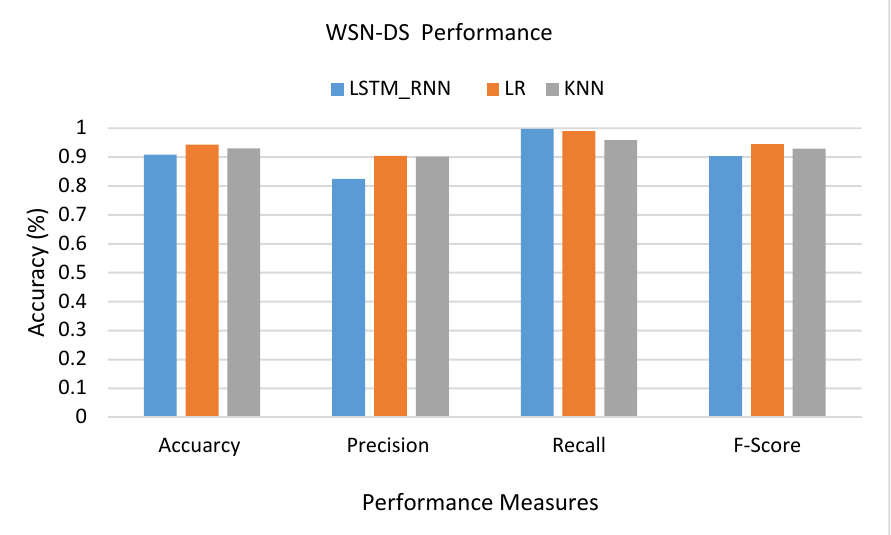
Figure 21. WSN-DS Binary classification performance comparison.